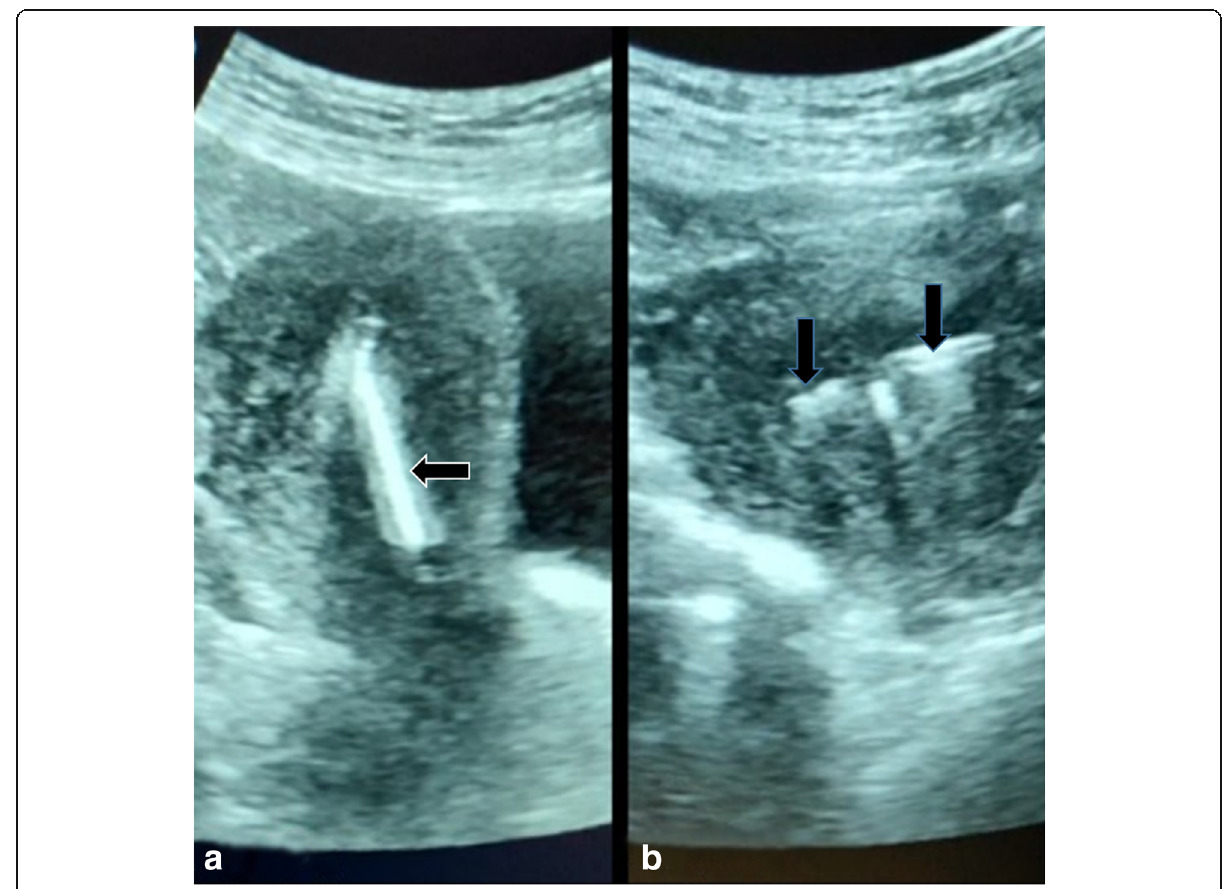
Fig. 9 Sagittal ( a ) and axial ( b ) transabdominal ultrasound images of intra-uterine Contraceptive device (black block arrows) mimicking endometrial